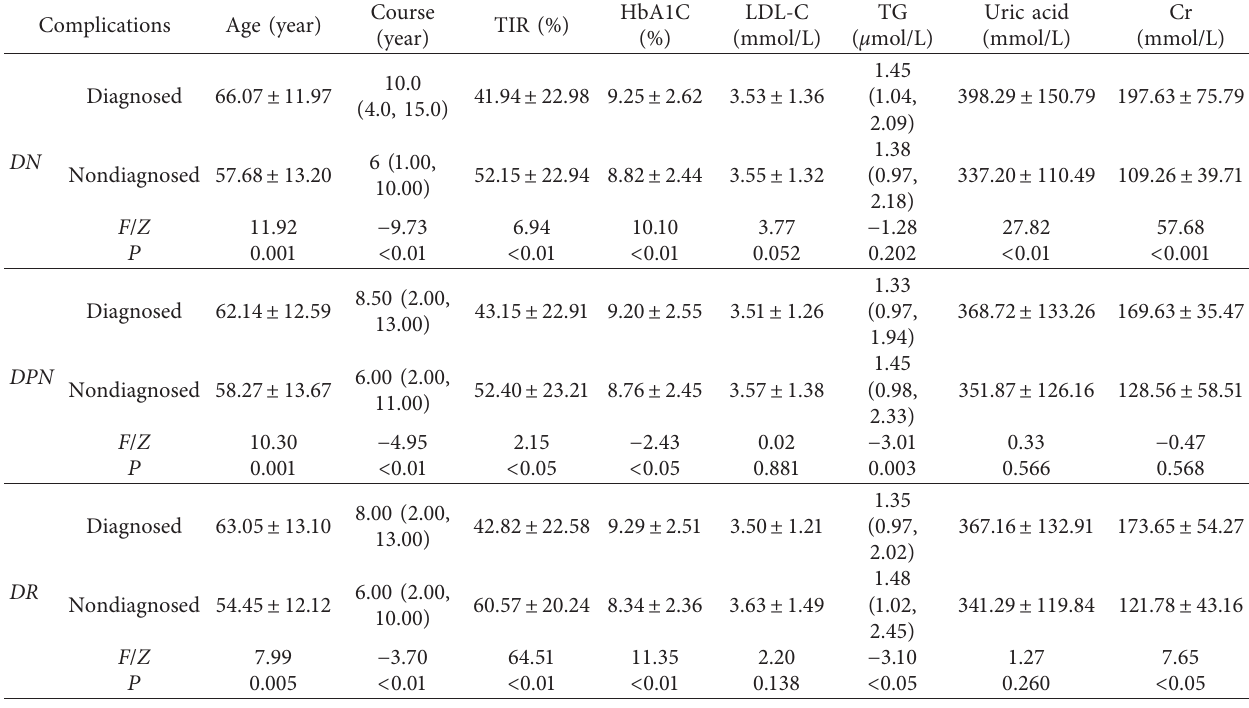
Table 1: The basic information for the